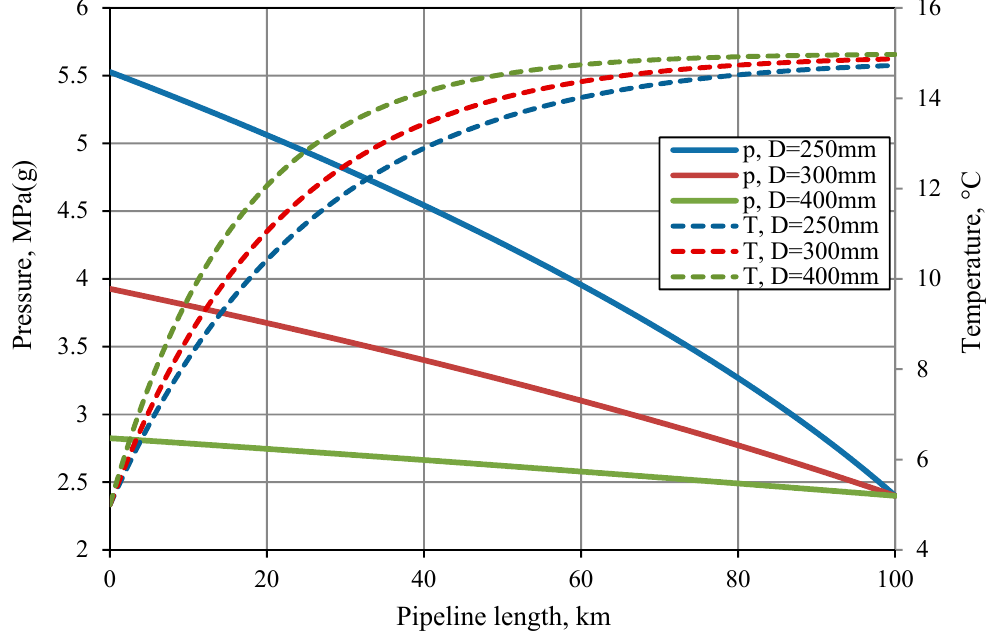
Figure 9. Pressure ( p ) (continuous lines) and temperature ( T ) (dashed lines) changes for hydrogen mass flow rate of 3.0 kg/s (120,000 Nm 3 /h) for different diameters.